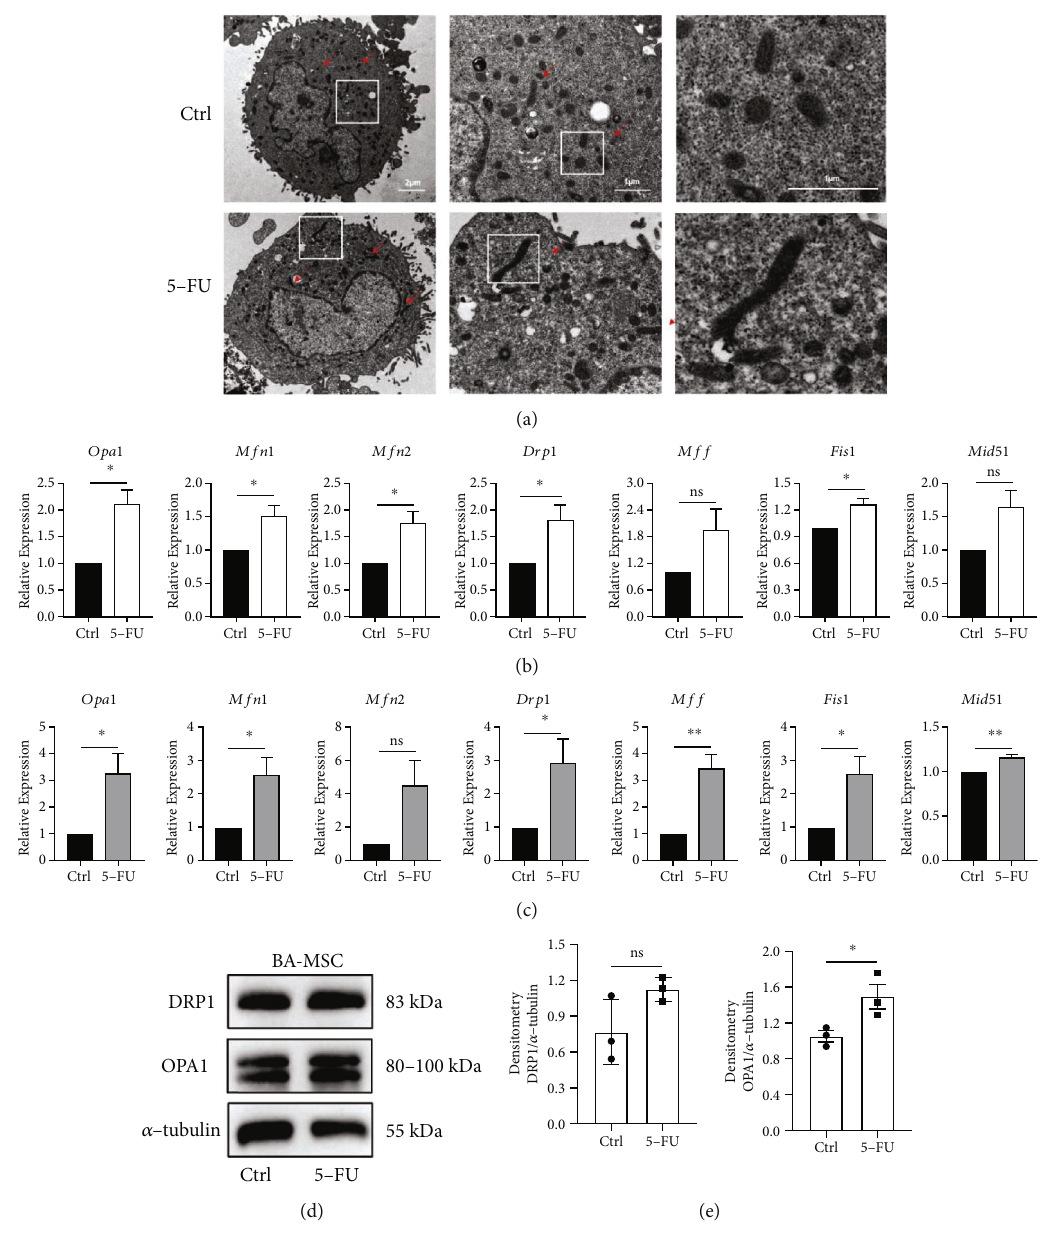
Figure 3: Analysis of mitochondrial dynamics in BA-MSCs after 5-FU chemotherapy. (a) TEM images depicting morphological changes of mitochondria (white rectangles) in control BA-MSCs and 5-FU-injured BA-MSCs. Scale bar, 2 μ m, and 1 μ m. (b) Gene expressions of Opa1 , Mfn1 , Mfn2 , Drp1 , M ff , Fis1 , and Mid51 in DMSO-treated BA-MSCs and 5-FU-treated BA-MSCs were detected by qRT-PCR ( n = 5 ). (c) Gene expression of Opa1 , Mfn1 , Mfn2 , Drp1 , M ff , Fis1 , and Mid51 in control mice and 5-FU-induced myelosuppression mice were detected by qRT-PCR ( n = 5 ). (d) Protein expression of DRP1 and OPA1 in DMSO-treated BA-MSCs and 5-FU-treated BA-MSCs were detected by western blotting. (e) Western blotting analysis of DRP1 and OPA1 in DMSO-treated BA-MSCs and 5-FU-treated BA-MSCs ( n = 3 ). All data are presented as mean ± SEM . Statistics: unpaired Student ’ s t -test (ns: not signi fi cant; ∗ p < 0 : 05 and ∗∗ p < 0 : 01